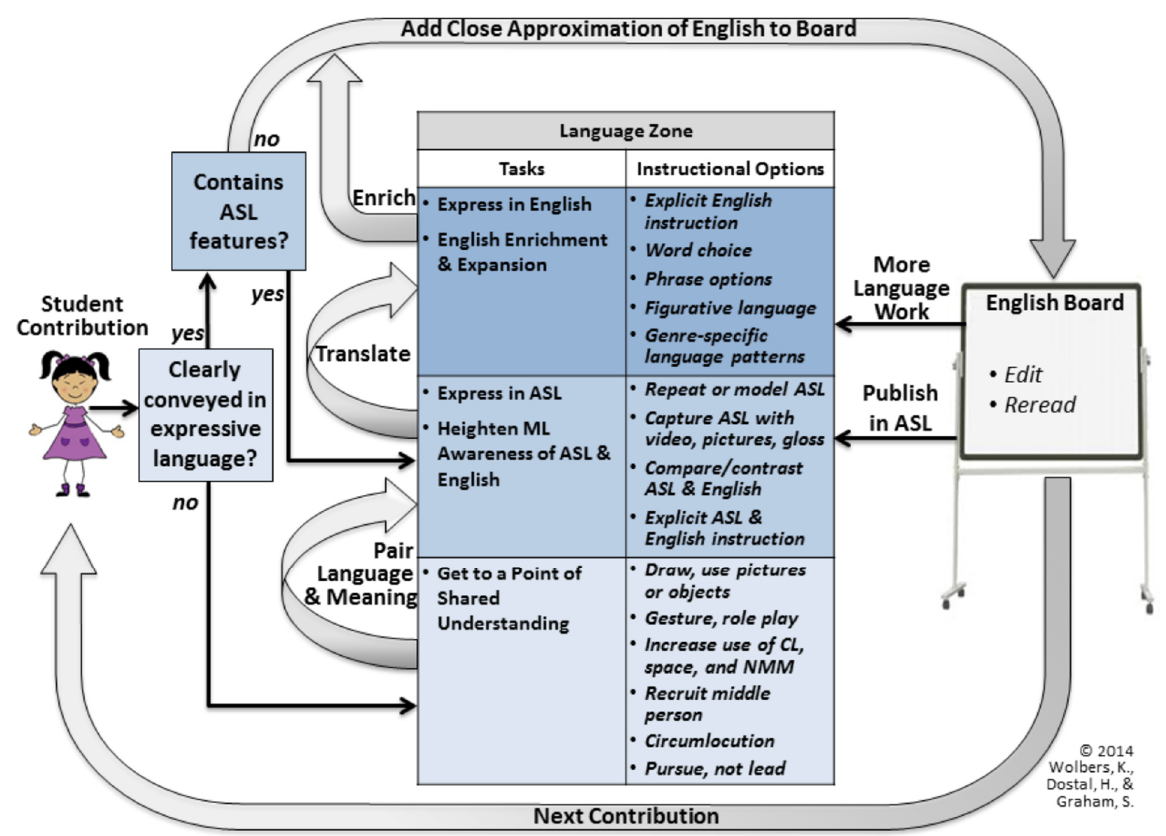
Figure 2. Language Zone flow chart of teacher decision making.